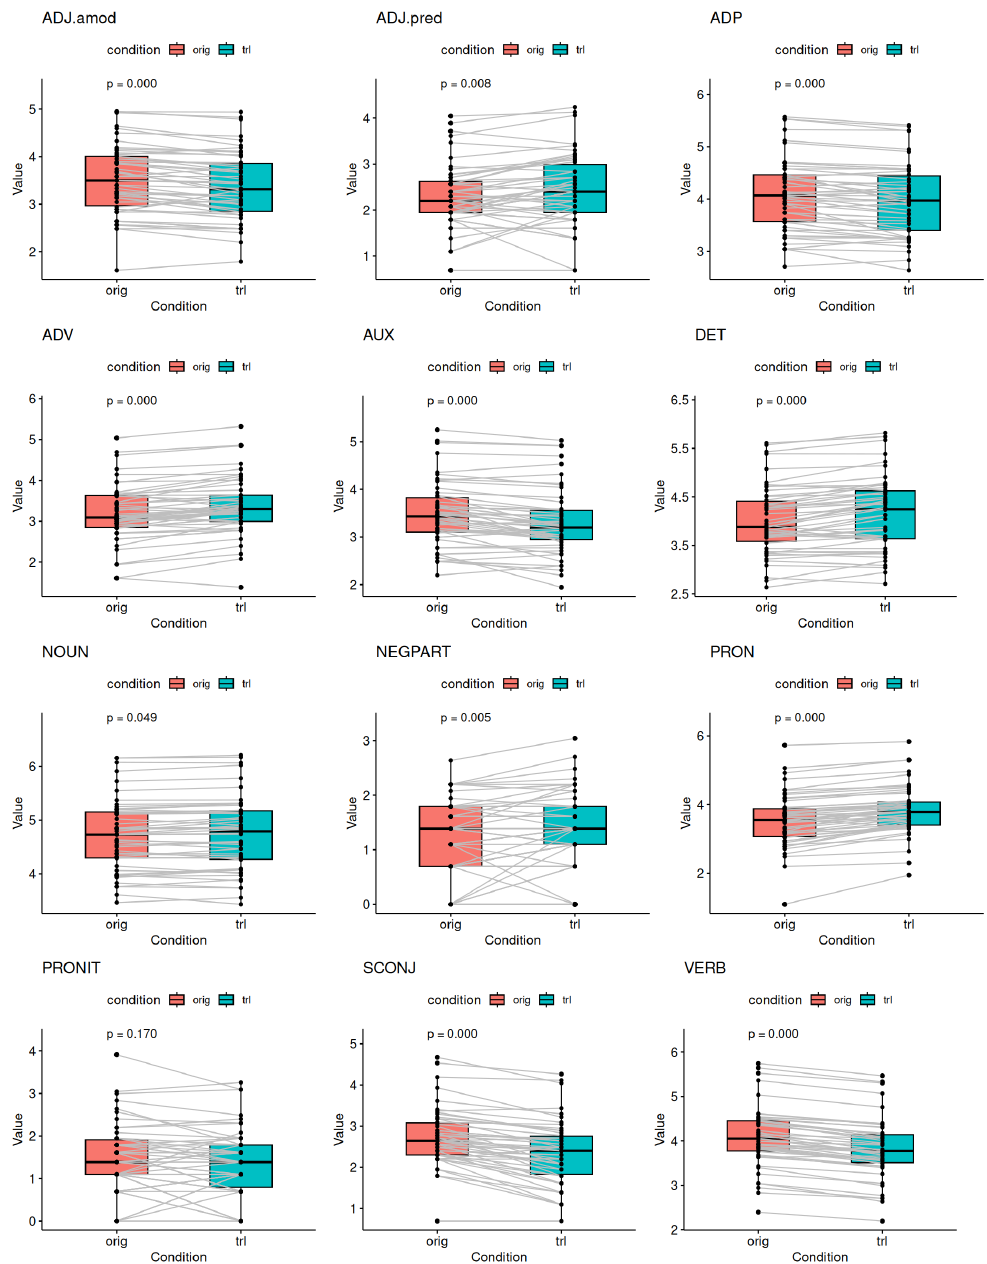
Figure A3. Pairwise comparisons of POS-frequencies (log-transformed) per speech in originals and translations. Each line connects data points representing the same speech (orig: original, trl: